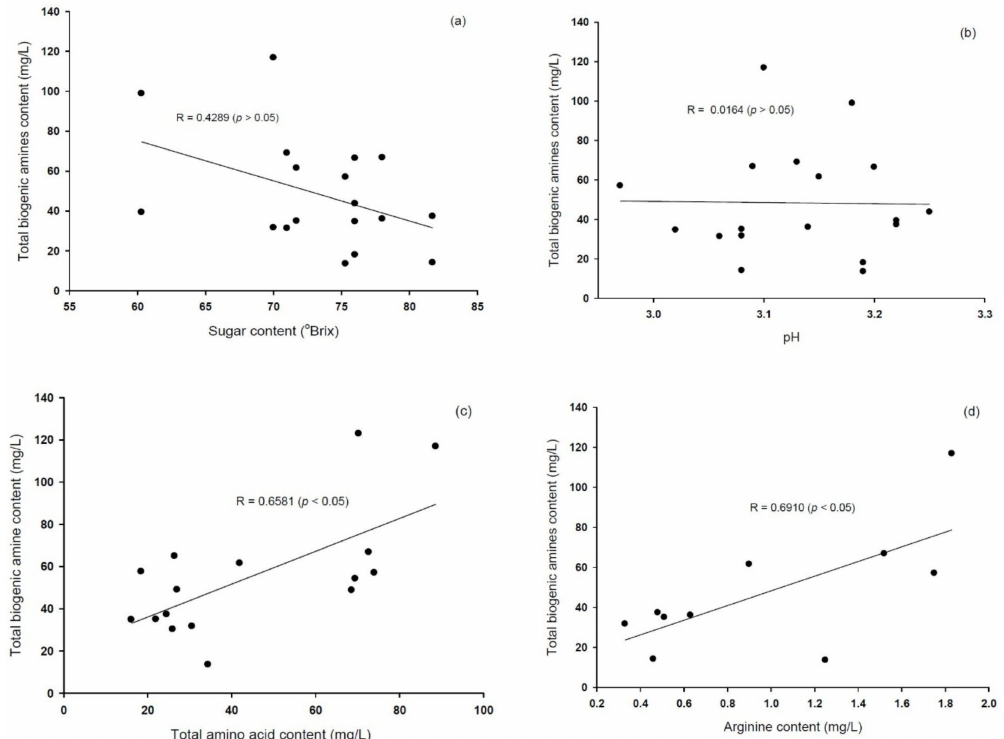
Figure 3. Correlations between sugar content and biogenic amine content (mg / L) ( a ); pH and biogenic amine content (mg / L) ( b ); the content (mg / L) of total amino acid and total biogenic amines ( c ); and the content (mg / L) of biogenic amines and arginine ( d